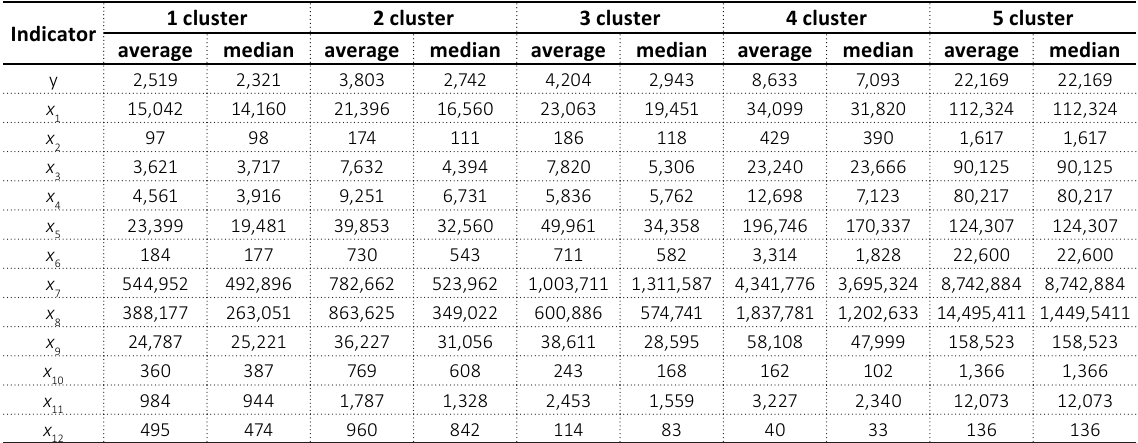
Table 10. Average and median values by